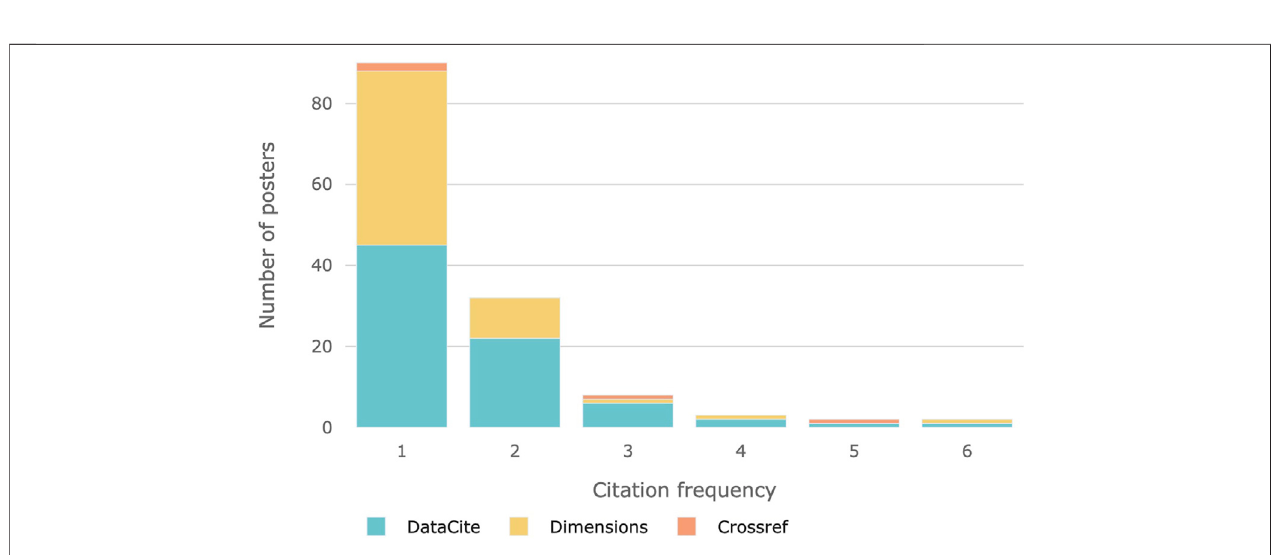
FIGURE 2 | Cited posters to citation